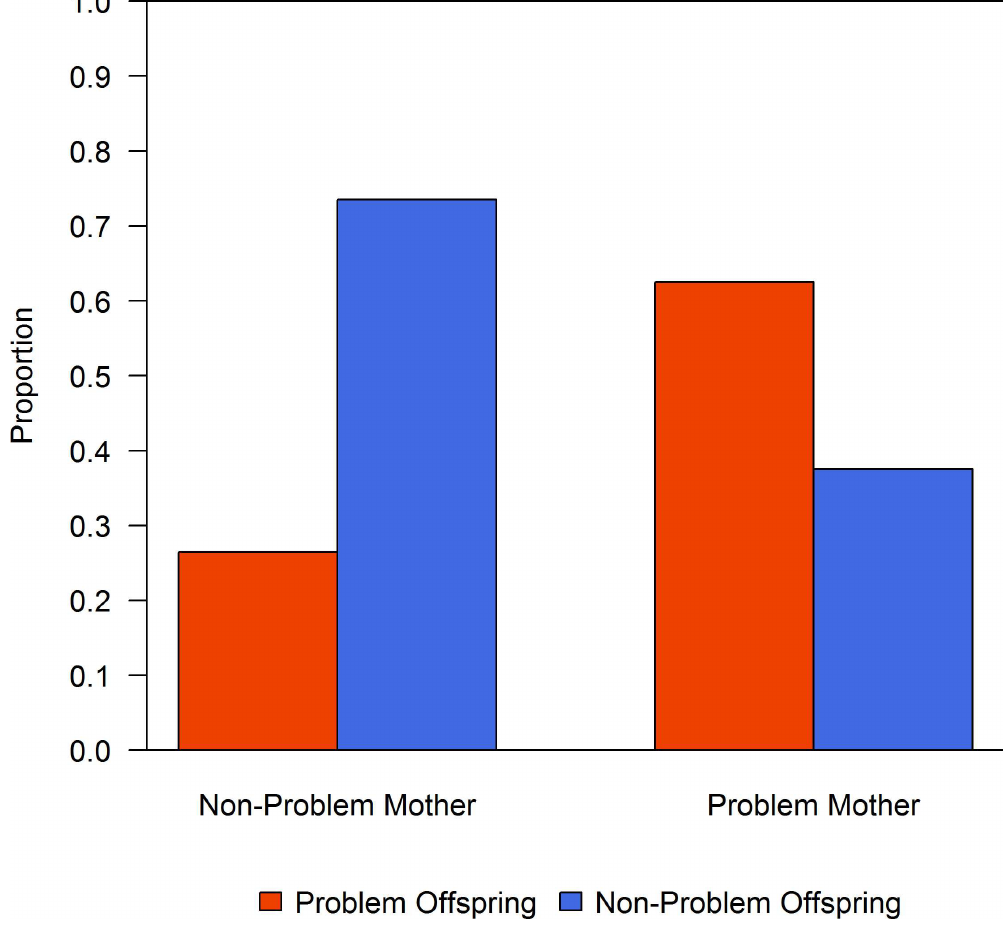
Fig 3. Mother-offspring behaviours. Frequency of problem and non-problem offspring groupedby behaviour type of their mother.